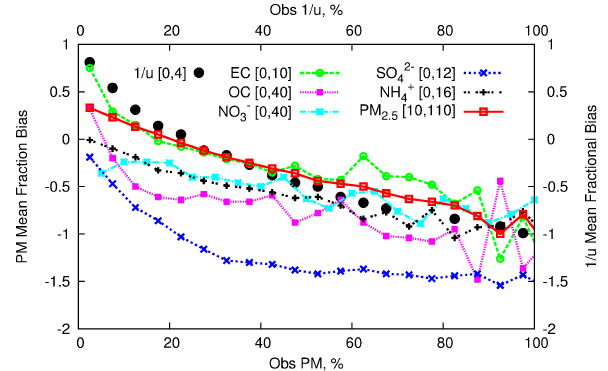
Figure 9. Association between predicted PM concentration bias and wind bias vs. observed values. The observed PM concen- trations and 1/ u values on the x axis are expressed in a rela- tive scale of 0–100% of maximum range calculated as x (%) = (C − C min )/( C max − C min ) × 100. Values for [C min , C max ] are listed in the concentration key. Bias between predicted vs. observed values is shown on the y axis. Ideal behavior is bias of zero at all concen- trations and wind